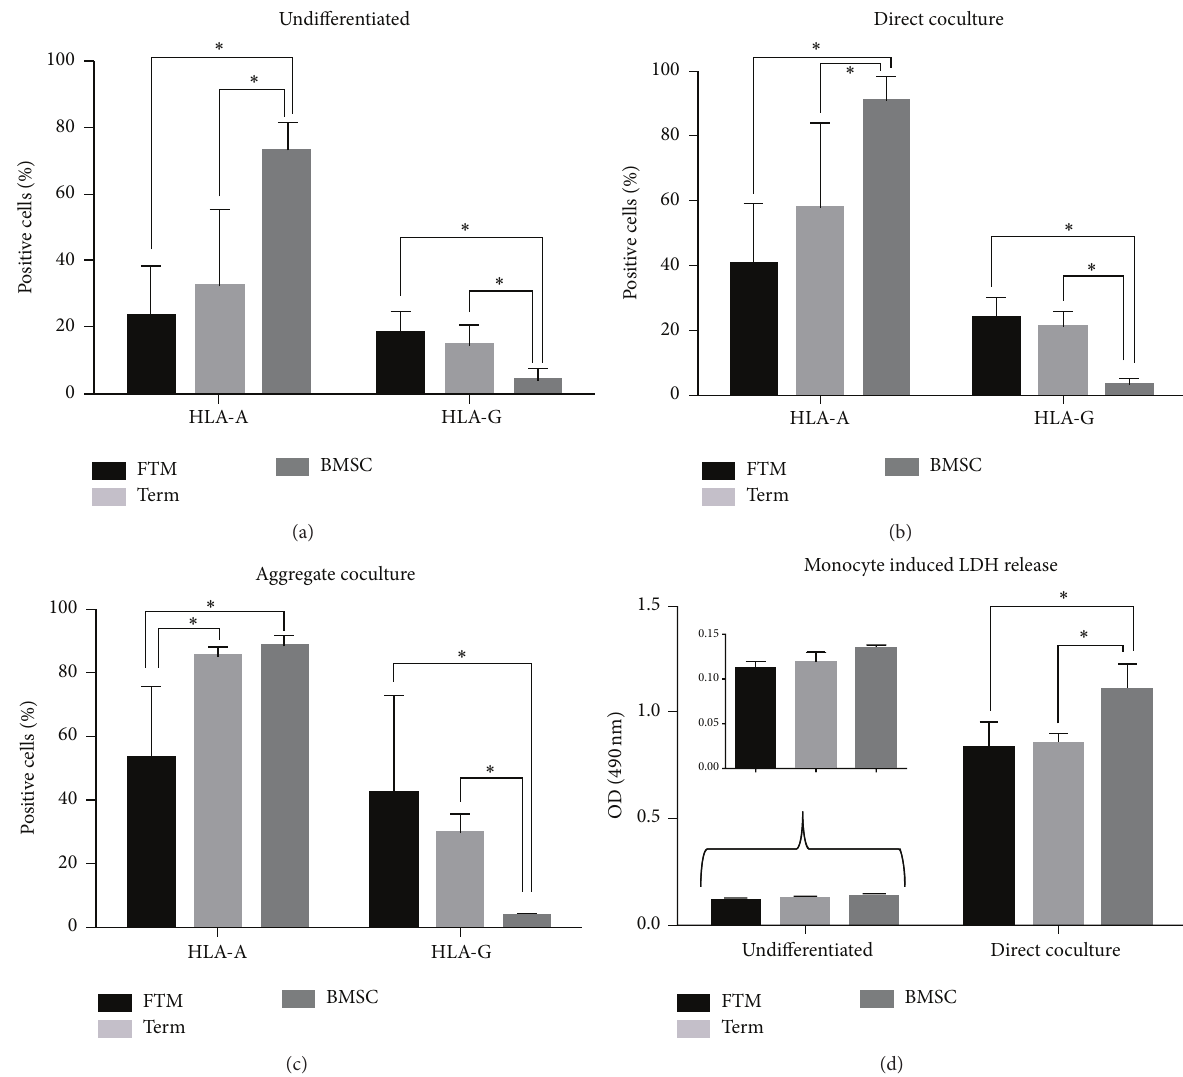
Figure 3: Immunological characteristics of hMSCs before and after cardiac differentiation in vitro . (a–c) FC analysis of HLA-A and HLA- G expression in (a) undifferentiated, (b) direct coculture, and (c) aggregate coculture differentiated FTM and term HUCPVCs and bone marrow MSCs (BMSCs). Values expressed as % of overall human cell number in corresponding cultures. (d) Colorimetric analysis of human leukocyte induced LDH release after 72 h of incubation with FTM and term HUCPVCs and BMSCs sorted from cardiomyocyte cultures (direct cocultures) compared to undifferentiated MSC cultures. Values expressed as optical density (OD) of LDH converted substrate detected at 490 nm. Inner graph shows undifferentiated MSC values ( 𝑦 -axis 3x of main graph). Asterisk indicates statistically significant difference ( 𝑝 < 0.01 , 𝑛 FTM = 9 , 𝑛 term = 9 , 𝑛 BMSC = 6